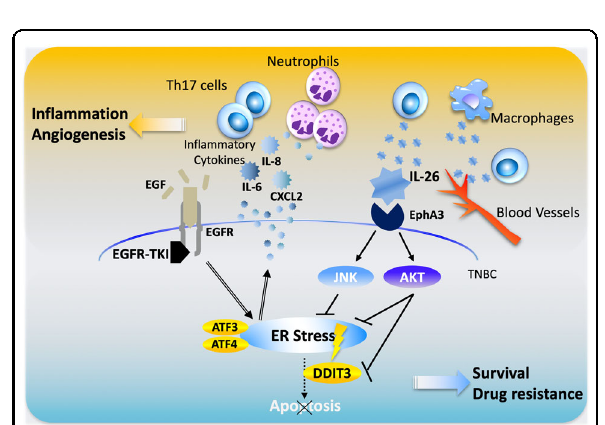
Fig. 7 Hypothetical schema of the effect of IL-26 on EGFR-TKI resistance. IL-26 activates AKT and JNK signaling of bypass pathway of EGFR-TKI via interaction with its newly identi fi ed IL-26 functional receptor EphA3, leading to suppression of EGFR-TKI-induced ER stress, which subsequently results in TNBC tumor survival and drug resistance. Moreover, production of ER stress-associated in fl ammatory cytokines/chemokines including IL-6, IL-8, and CXCL2 was enhanced following treatment with EGFR-TKI, leading to the recruitment of neutrophils in TME, which further promotes the in fl ammation and recruitment of other in fl ammatory cells such as T cells and